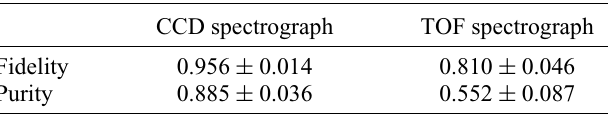
TABLE I. Average fidelities and purities of the reconstructed POVM elements for d = 5 with the corresponding standard deviation.